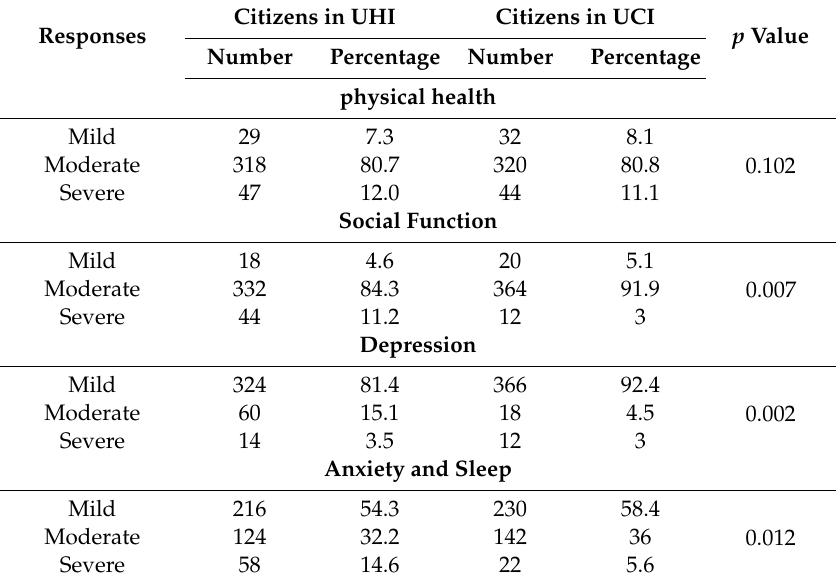
Table 3. Summary of GHQ-28 results and statistical comparing of GHQ-28 sub-scales (i.e., physical health, social function, depression, and anxiety and sleep) in two groups of citizen (urban heat island (UHI) and urban cold island (UCI)) based on Mann–Whitney test (at 95% confidence